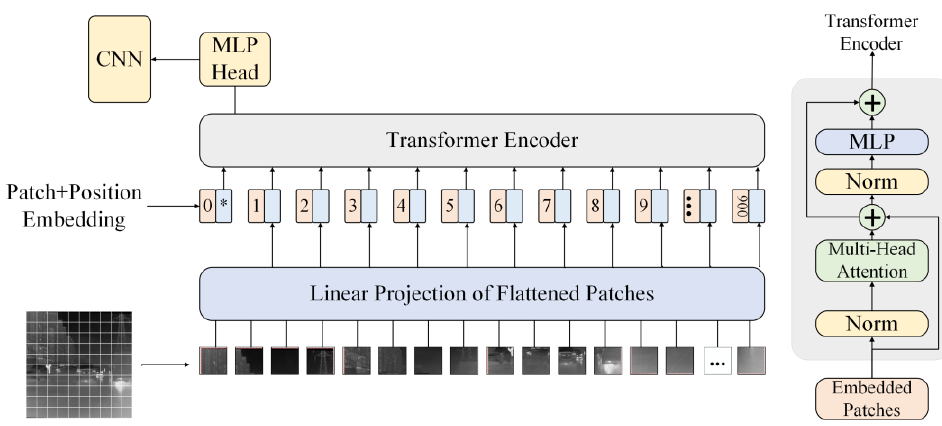
Figure 7. Structure of the Vit module.